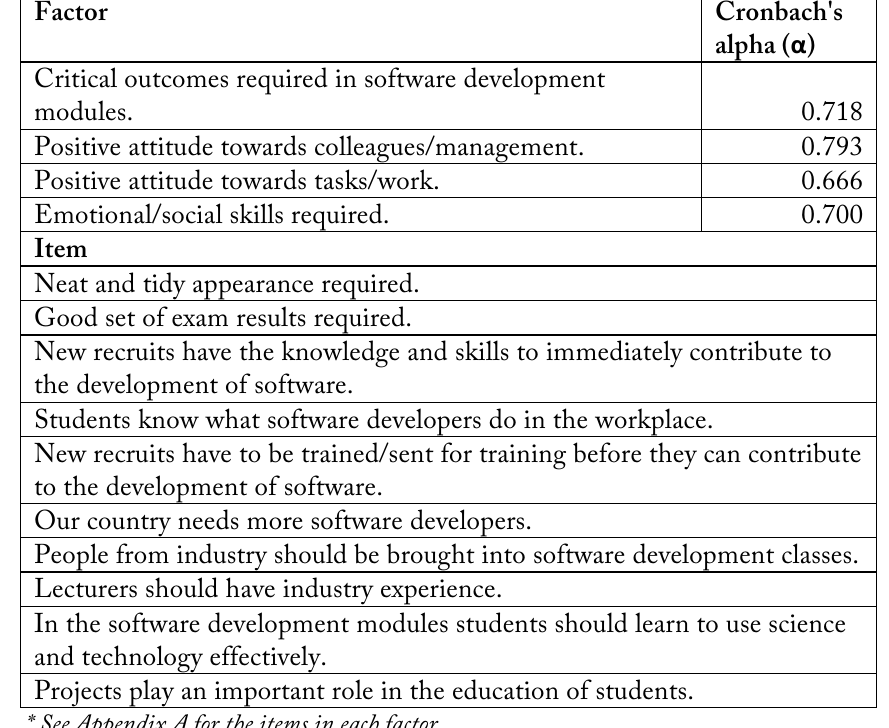
Table 2: Factors* (with reliability coefficients) and items